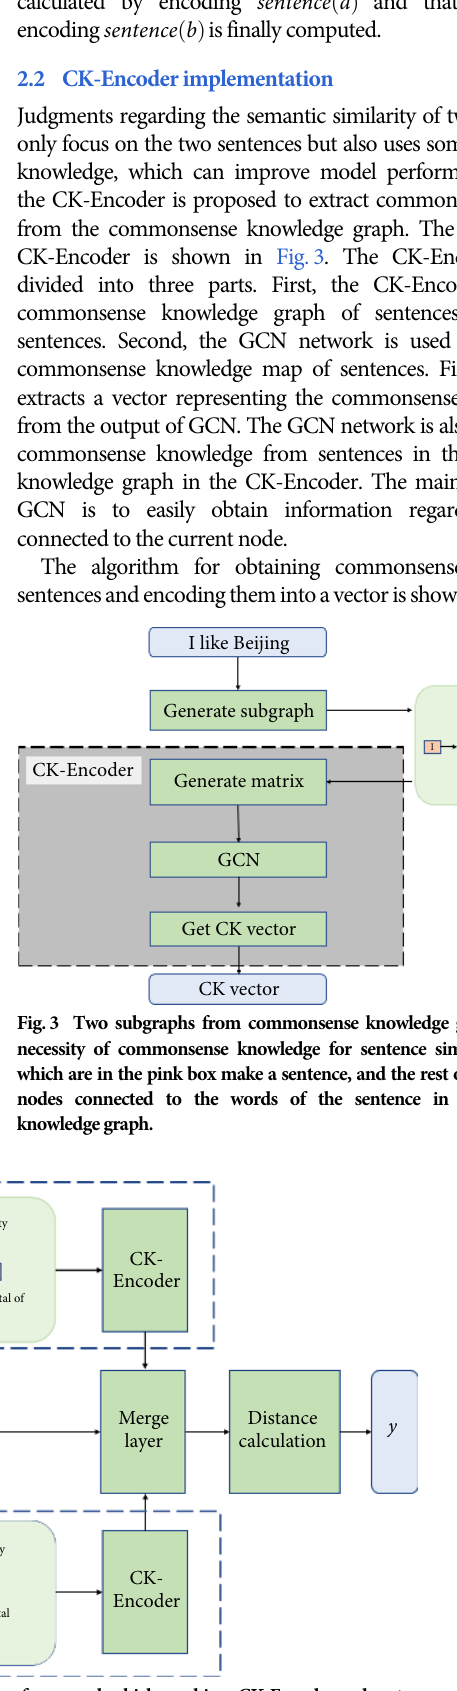
Fig. 2 Framework of CKER for sentence similarity modeling. CKER is a framework which combines CK-Encoder and sentence encoder.